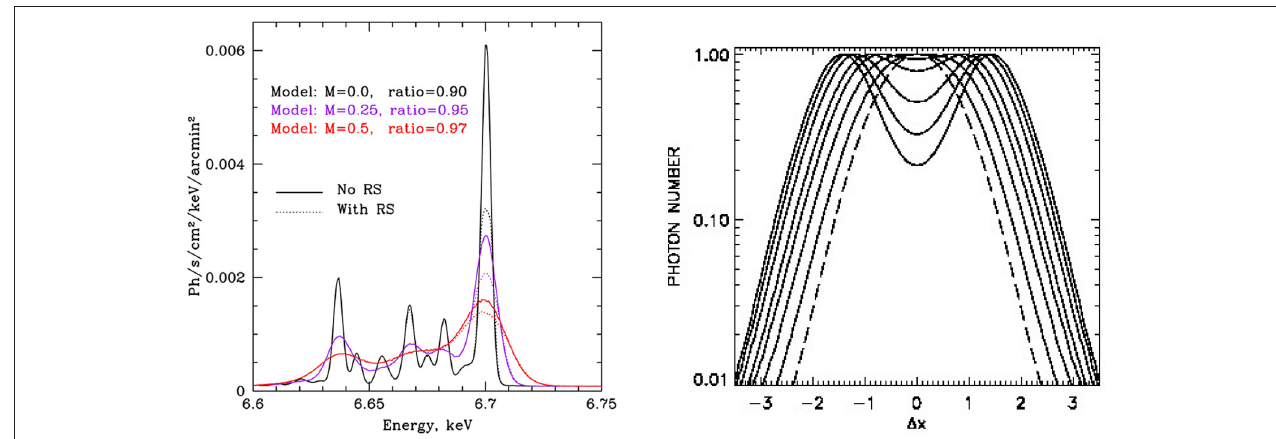
FIGURE 2 | Comparison between different line shapes from clusters due to turbulence and resonant line scatterings. Left panel: Simulated spectra of the emerging line from the Perseus cluster with and without resonant scattering (solid and dotted lines), and with and without turbulence (M = 0.5, 0.25 and 0, in units of the Mach number of the turbulent velocity; Figure 6 from Zhuravleva et al., 2013). Right panel: Shapes of emerging lines due to resonant scatterings with different optical depths from Monte Carlo simulations. Solid lines represent emergent lines with central optical depths of τ 0 = 0.5, 1, 1.5, 2, 3, 4, and 5 (5 is the broadest). The un-scattered, thermally broadened emission line is shown with a dashed line (from Molnar et al., 2006). The frequency shift is expressed in units of the thermal Doppler shift ( 1 x = 1ν/1ν D ).